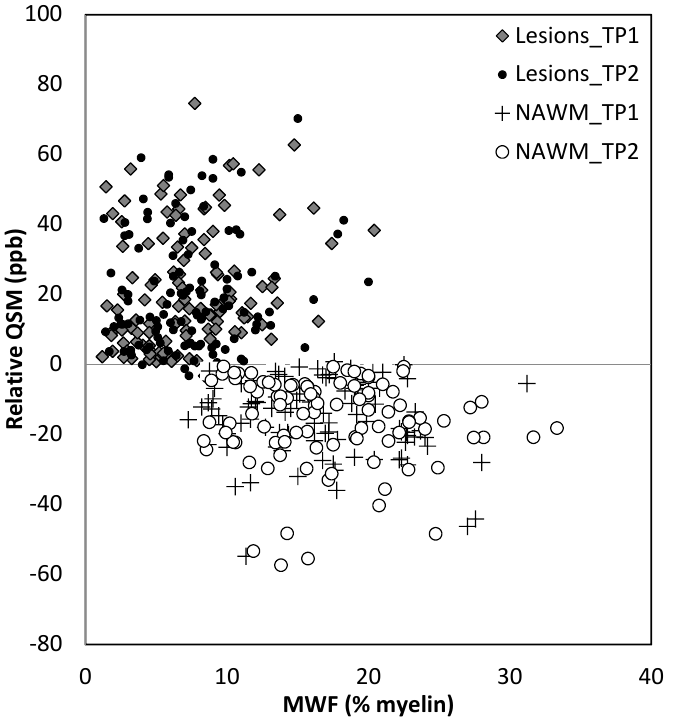
Figure 8. Relative QSM versus myelin water fraction (MWF). Lesions appear to have different susceptibilities and MWF for lesions compared to normal appearing white matter (NAWM). TP1: time point 1; TP2: time point 2.